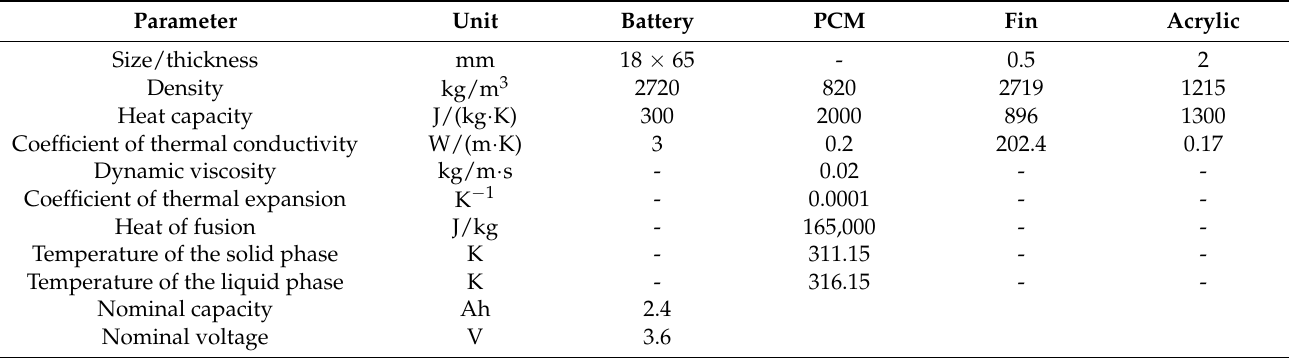
Table 2. Typical parameters of battery, PCM, fin and container